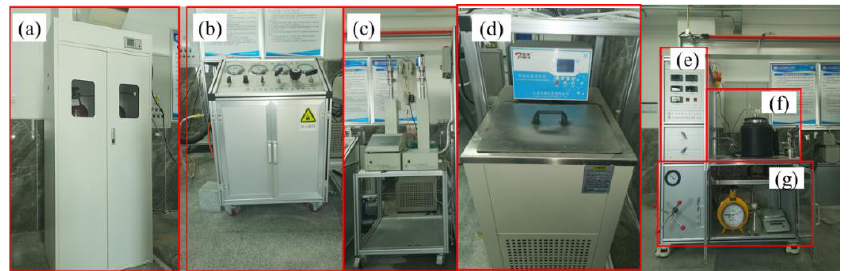
Figure 4. Physical diagram of hydrate synthesis and development system: ( a ) Gas cylinder; ( b ) Booster pump; ( c ) Syringe pump; ( d ) Water bath system; ( e ) Control panel; ( f ) High pressure reactor; ( g ) Metering system.